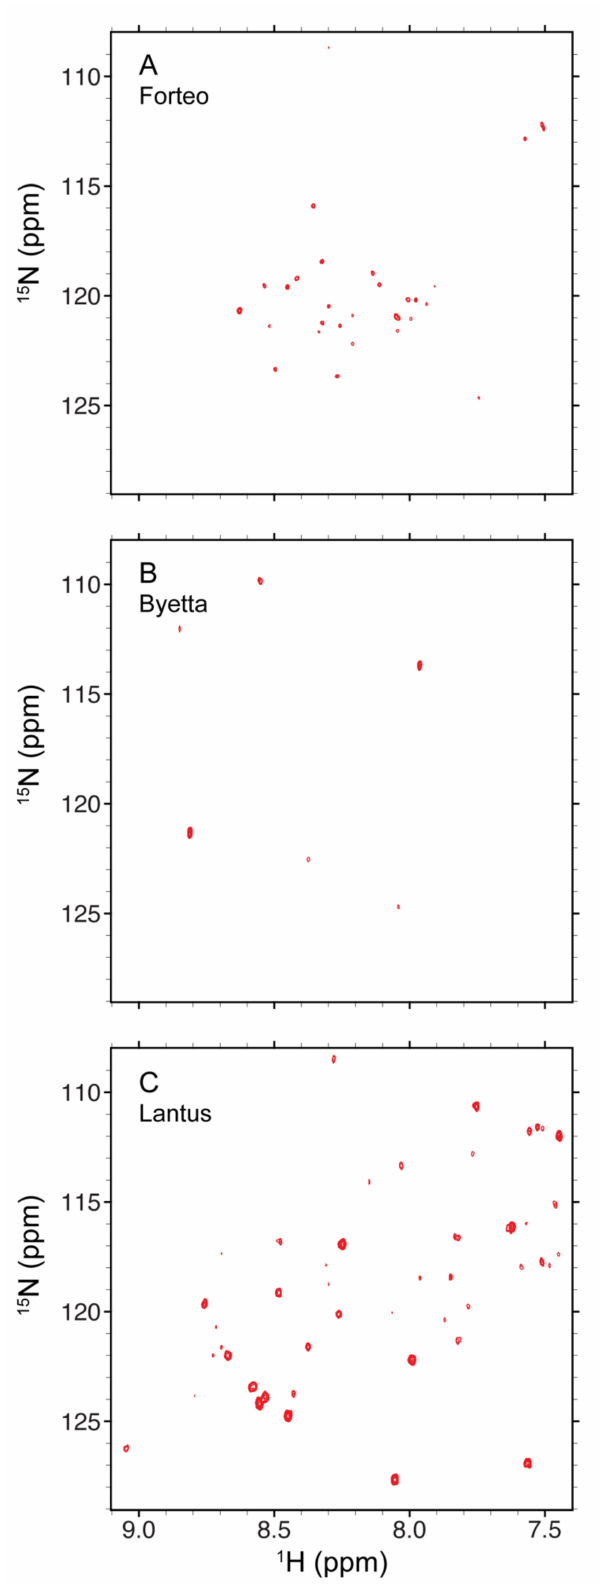
Figure 5. The 2D sofast 1 H- 15 N HMQC NMR spectra of teriparatide in Forteo ® ( A ), exenatide in Byetta ® ( B ) and insulin glargine in Lantus ® ( C ) collected using an 850 MHz spectrometer. The plotting threshold of intensity was at a signal to noise ratio of